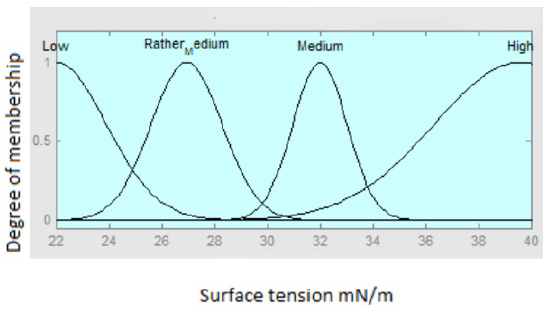
Figure 6. Membership function of surface tension as output variable.